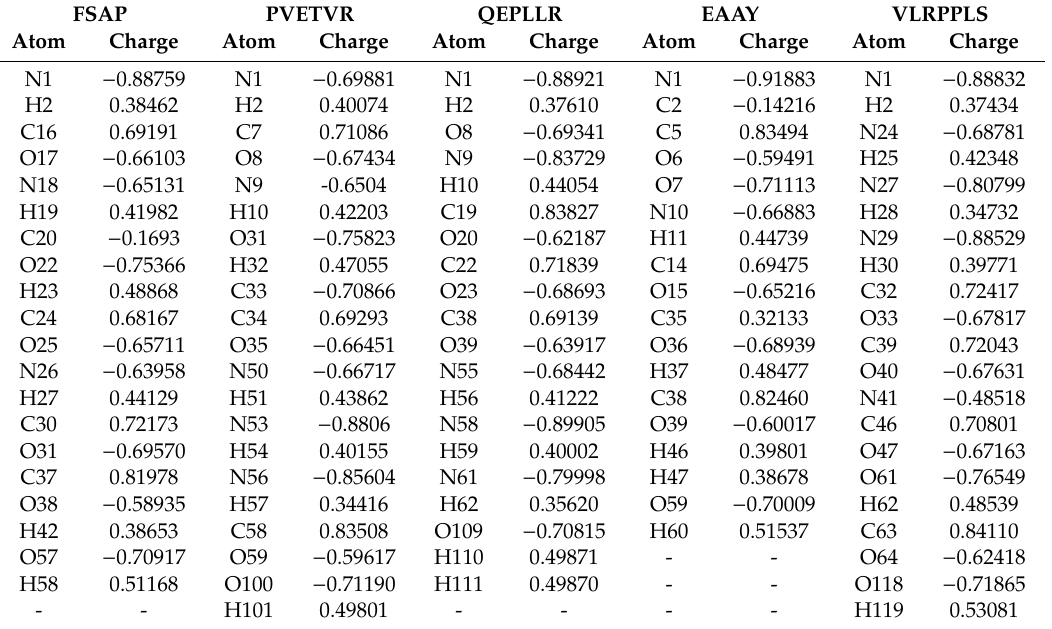
Table 3. Partial natural charge distribution of the five peptides was analyzed by natural bond orbital